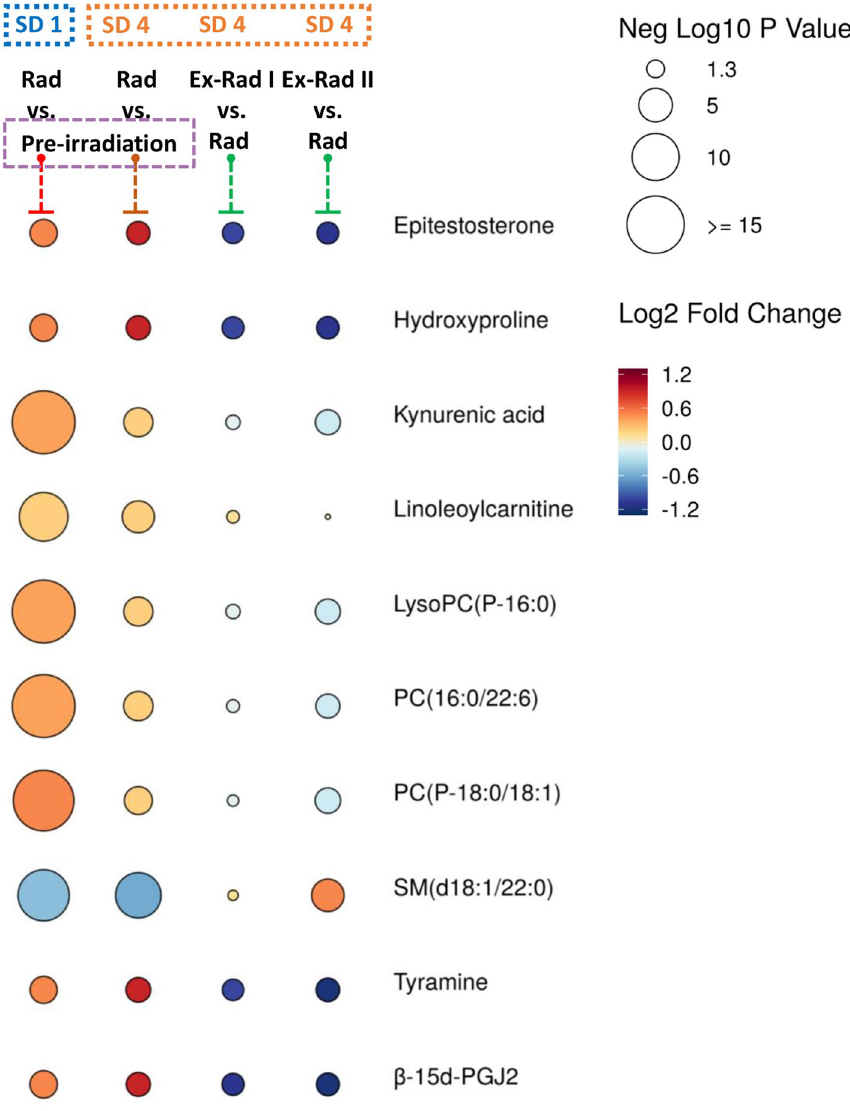
Figure 4. Raindrop plot illustration showing significantly altered metabolites by radiation in SD1, SD4, and then protected by Ex-Rad. Figure is created by open source software R (version 4.0.3, URL: https:// cran.r- proje ct.